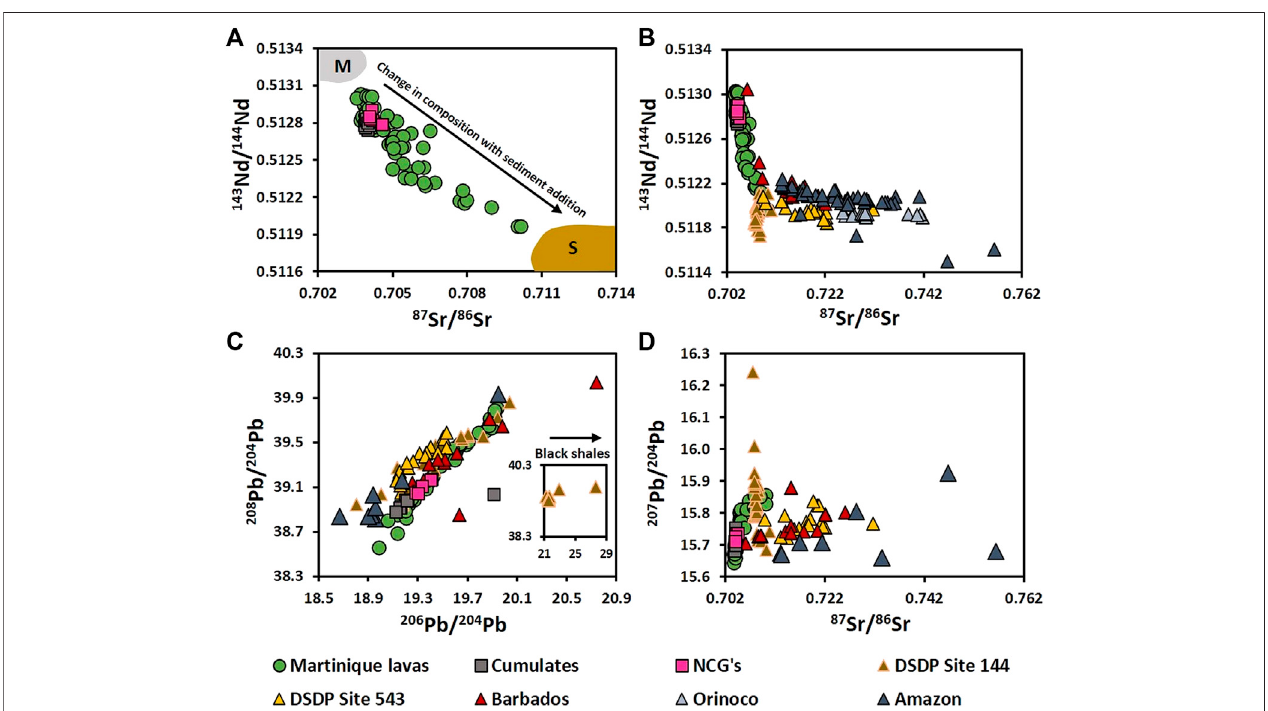
FIGURE 8 | (A) Whole rock 87 Sr/ 86 Sr vs. 143 Nd/ 144 Nd for Martinique lavas and plutonic xenoliths (this study), with schematic fi elds for mantle (M) and sediment (S) end members. As shown, a suitable sediment end member is likely to have more radiogenic Sr and less radiogenic Nd than the lavas. ( B), (C), and (D) 87 Sr/ 86 Sr vs. 143 Nd/ 144 Nd, 208 Pb/ 204 Pb vs. 206 Pb/ 204 Pb, and 87 Sr/ 86 Sr vs. 207 Pb/ 204 Pb, respectively, for Martinique lavas and plutonic xenoliths (this study), potential equivalents to subductedsediments(Site543,Site144,Barbados)andsedimentsfromtheOrinocoandAmazonrivers.Insetin C) showsdataforblackshaleunitofSite144.For all data points, uncertainty (2 SE) is smaller than symbol size. Data sources: Martinique lavas — Davidson (1986), Labanieh et al. (2010). Site 543, Site 144 and Barbados — Carpentieretal.(2008);Carpentieretal.(2009).Amazon — Allegreetal.(1996);Parraetal.(1997);Viersetal.(2008);Rousseauetal.(2019).Orinoco — Parra et al. (1997); Rousseau et al.